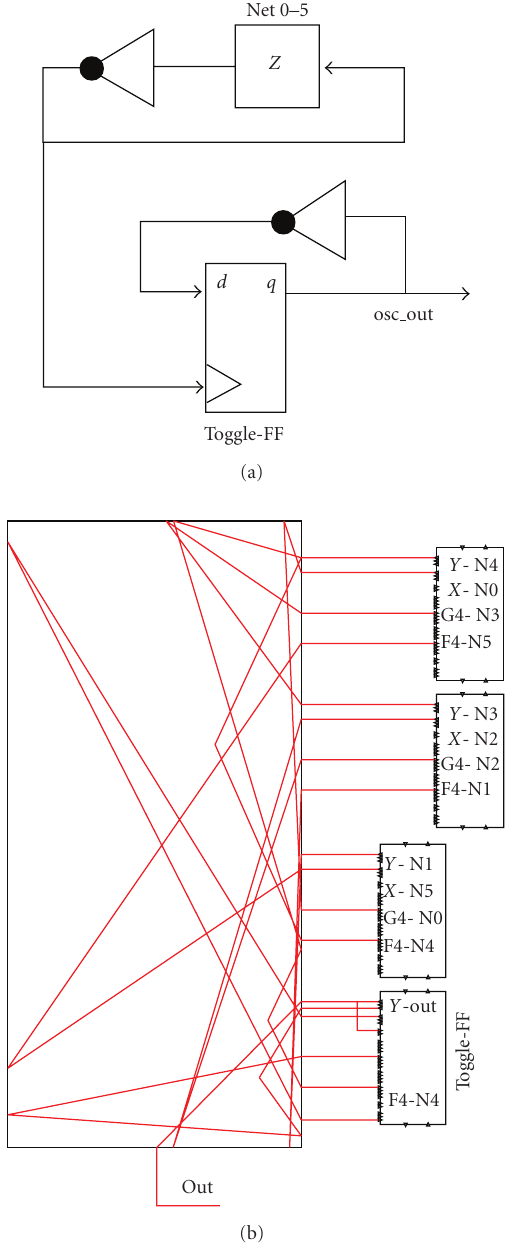
Figure 7: Oscillator macro zoom: (a) schematic and (b) physical FPGA Editor